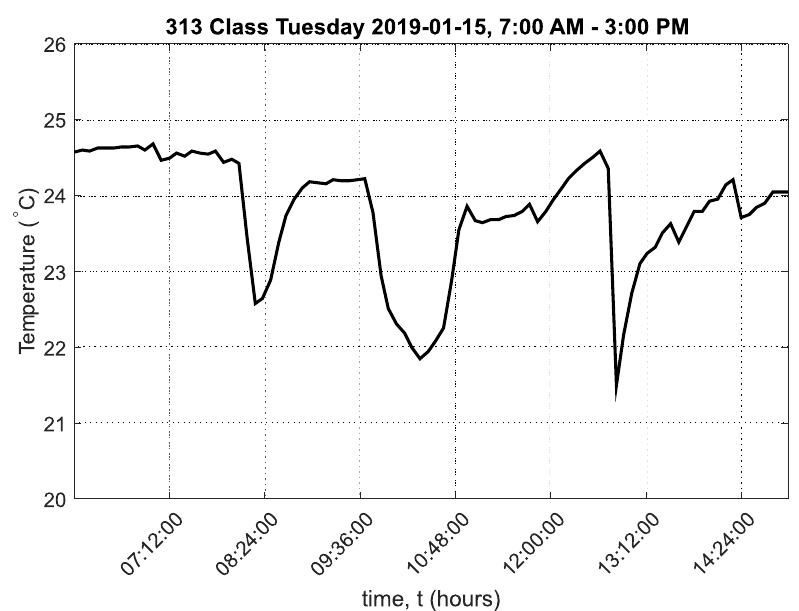
Figure A7. Graph of ambient temperature in classroom 313, Frenštát pod Radhoštˇem.